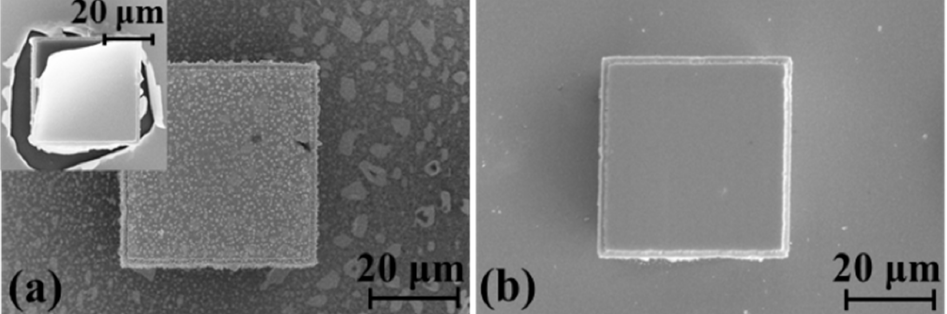
Figure 12. Silicon mould after TEM: ( a ) Ti/Pt/Au mould; ( b ) Ti/Pt mould.